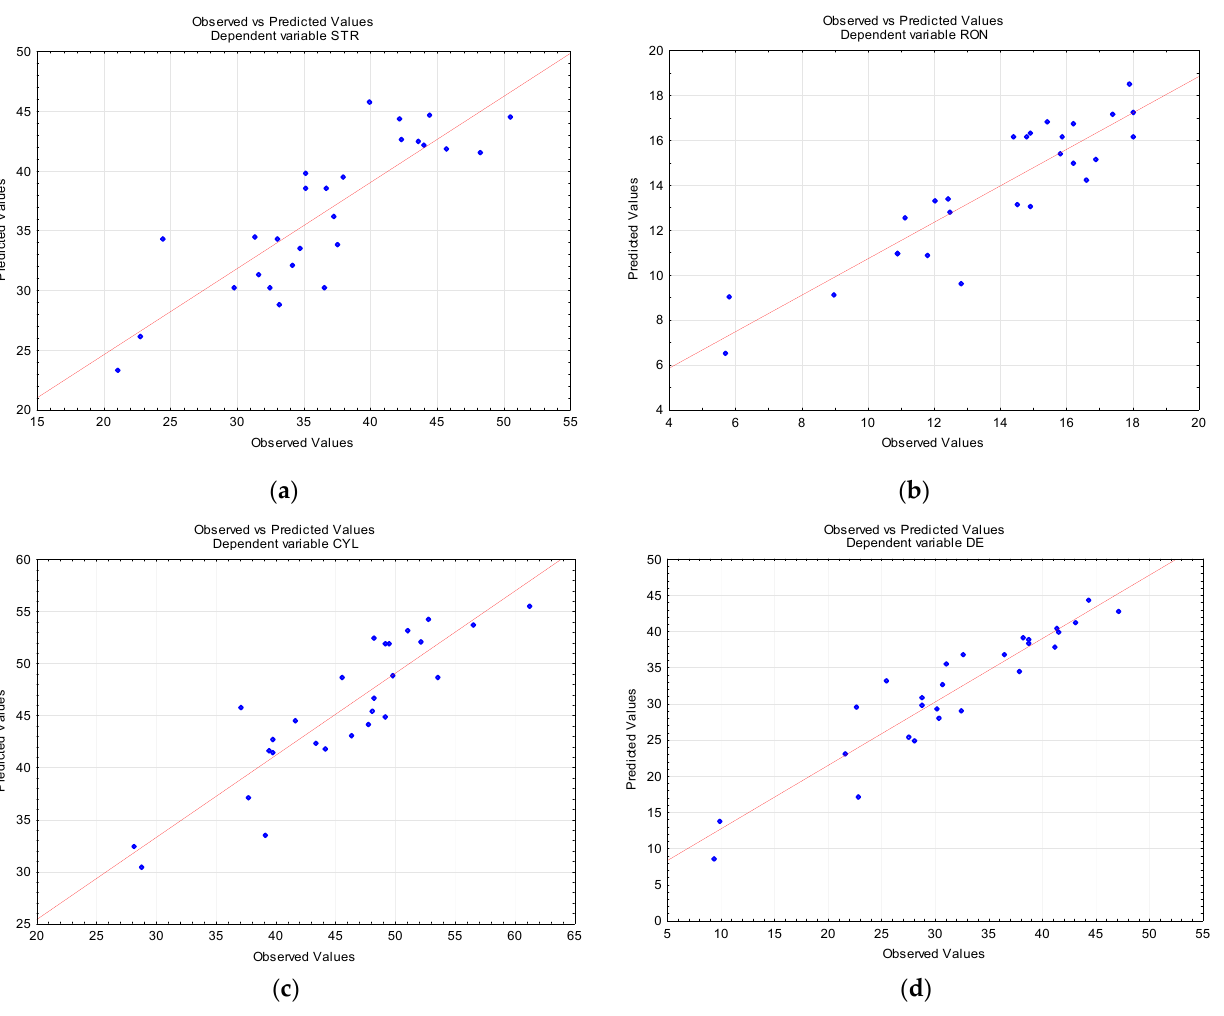
Figure 6. Observed vs. predicted values: ( a ) straightness error, ( b ) roundness error, ( c ) cylindricity error, ( d ) diameter error.